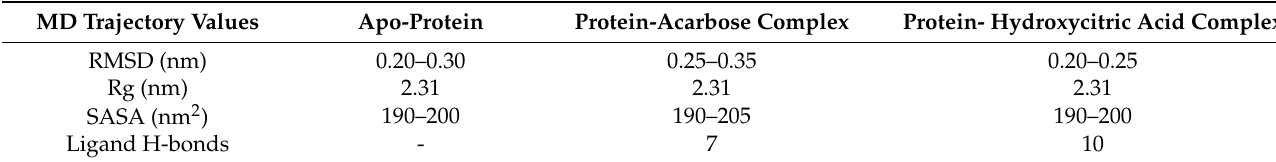
Figure 11. MD simulation trajectories plotted to show the comparative stability of ligands inside the inhibitor binding site of α -amylase ( A ) RMSD, ( B ) RMSF, ( C ) Rg, and ( D ) SASA, and ( E ) Ligand H-Bonds. Red: protein-acarbose; purple: protein-hydroxyacetic acid complex, and green: apo-protein. Table 12. MD values of hydroxycitric acid and acarbose complexes along with α